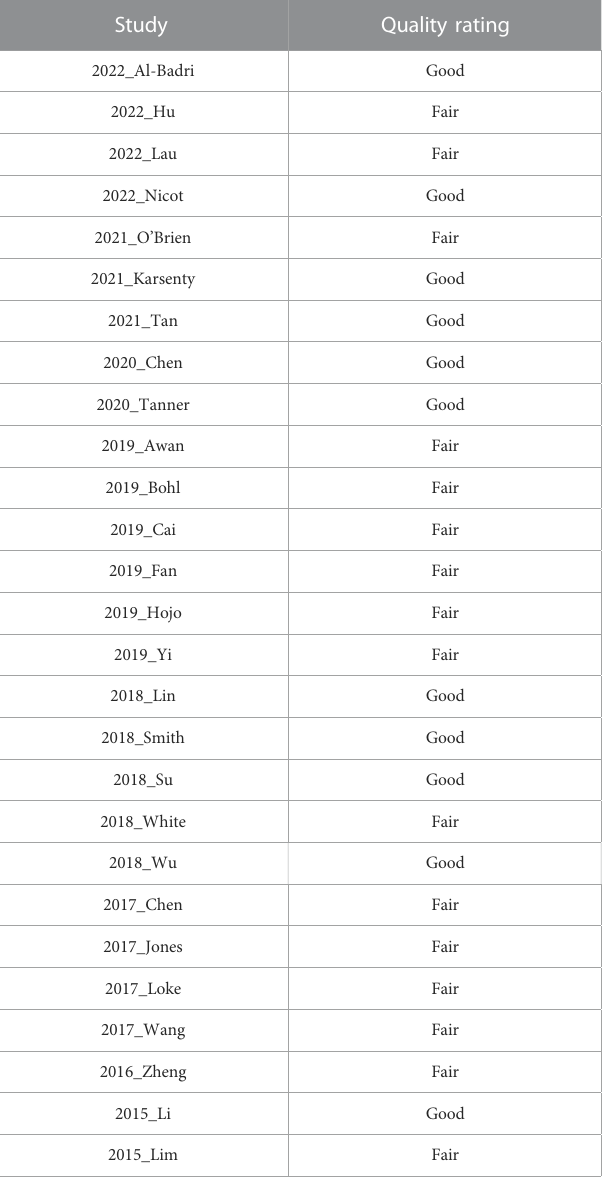
TABLE 2 Quality of the included studies assessed by National Institute of Controlled Intervention Studies tools.